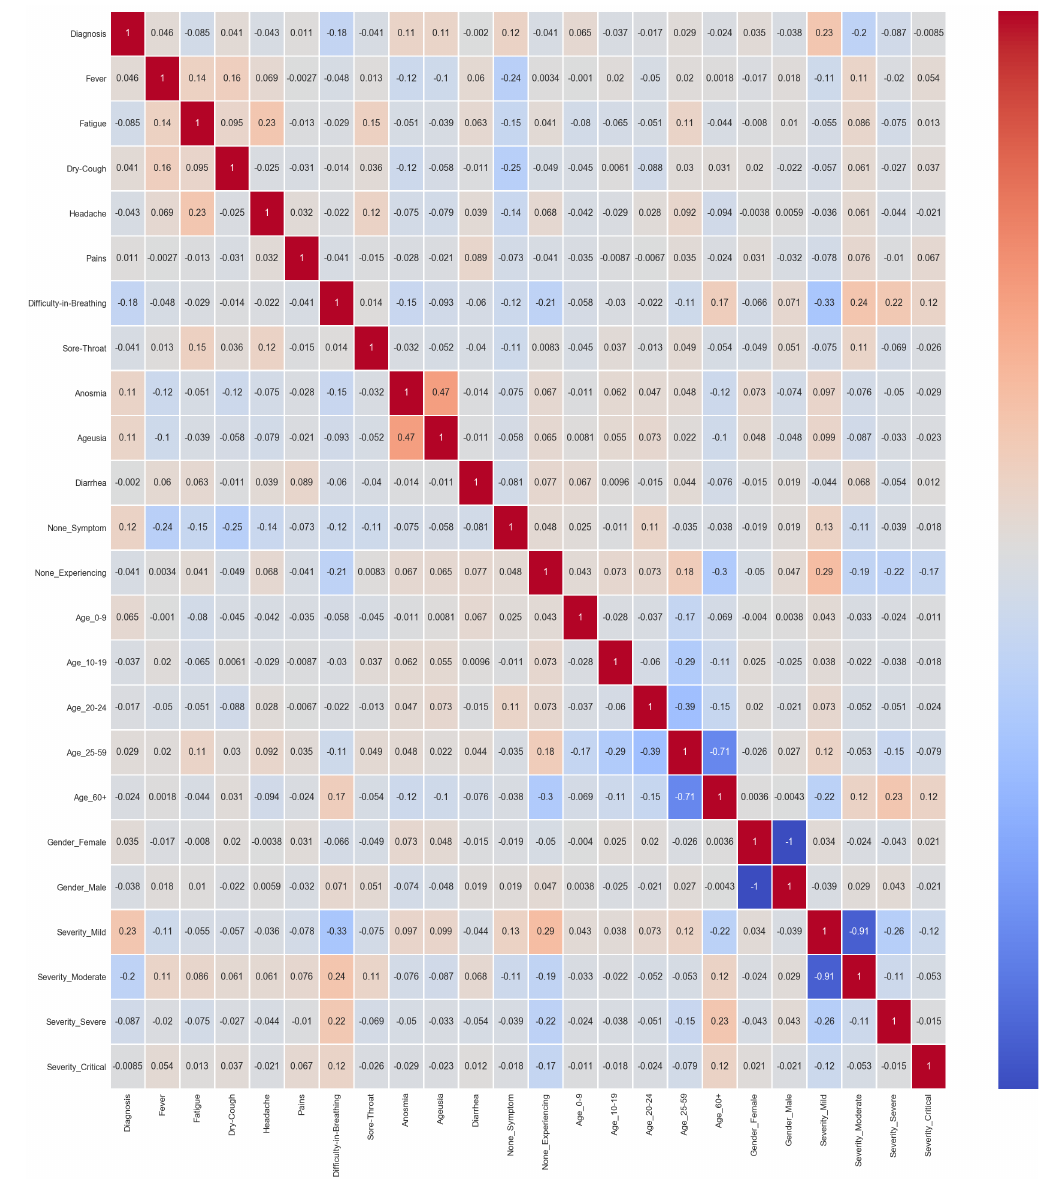
Figure 9. Correlation of all 24 features for the collected